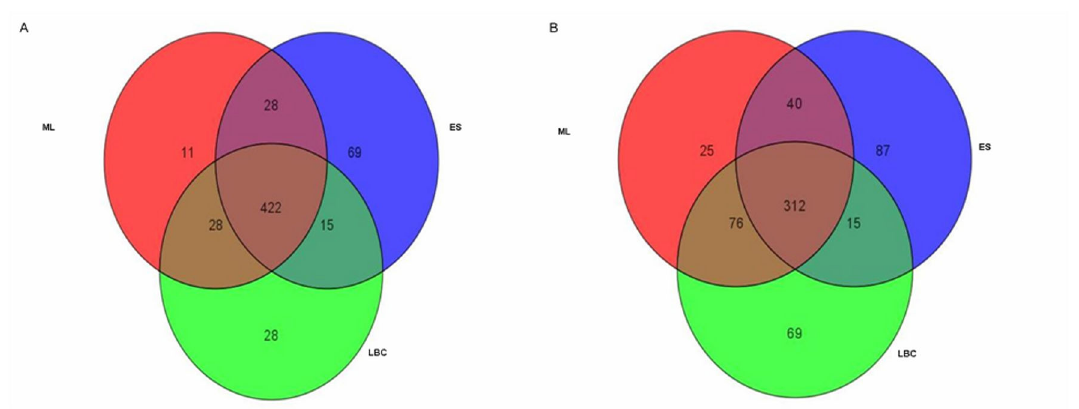
Figure 4. Venn diagrams showing the number of genes that were up-regulated (panel A) and down-regulated (panel B) with fold changes of ≥2.0-fold.